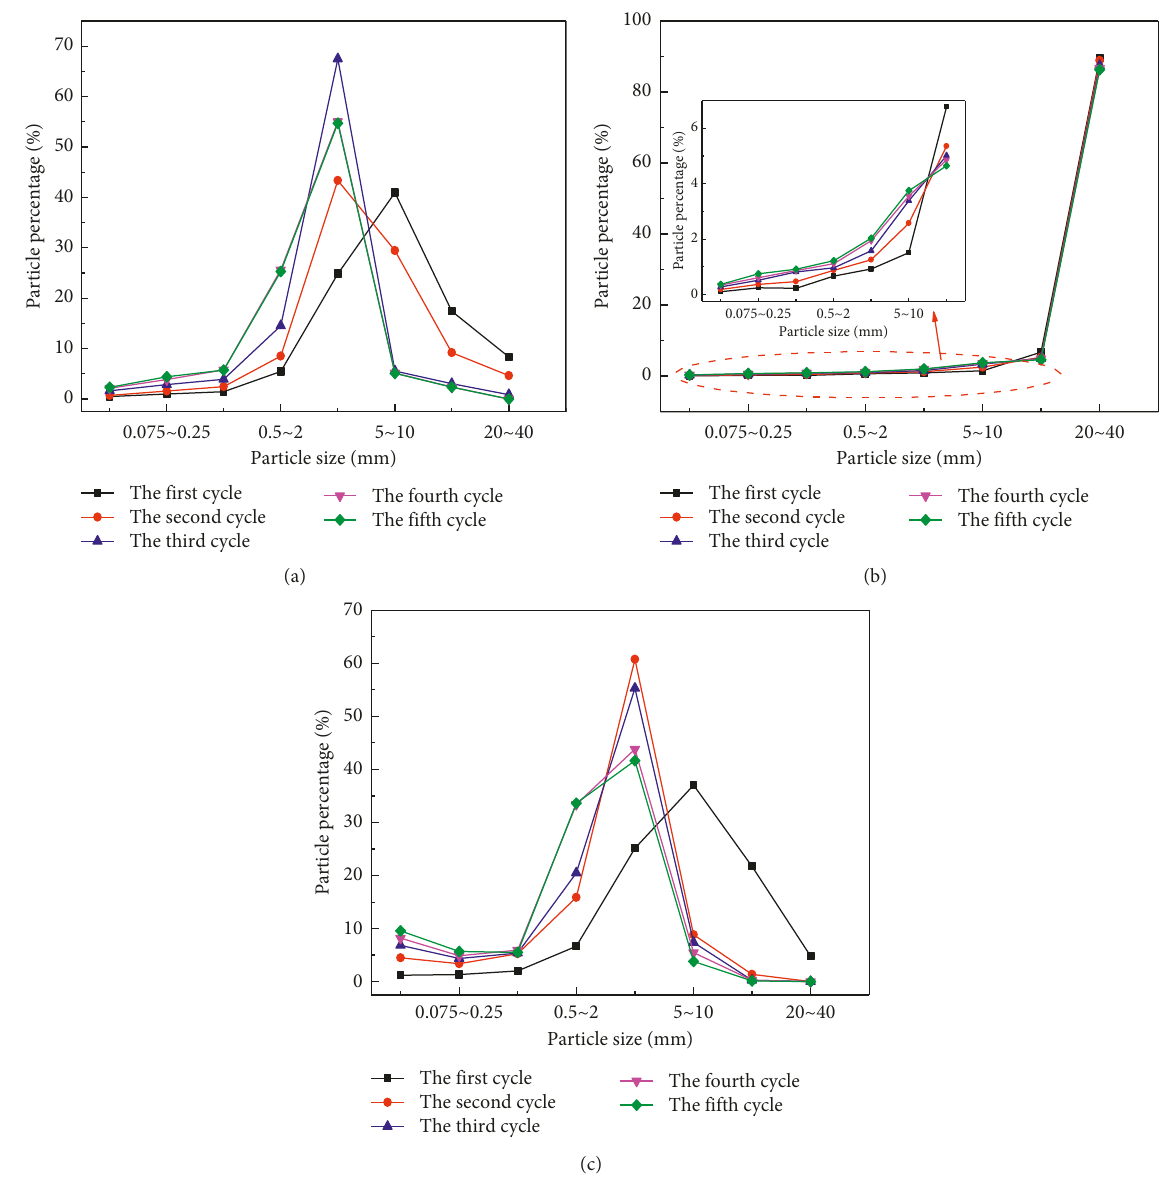
Figure 5: Percentage of disintegrating particles of the carbonaceous mudstone under different conditions. (a) Under the action of water. (b) Under the action of heat. (c) Under the action of